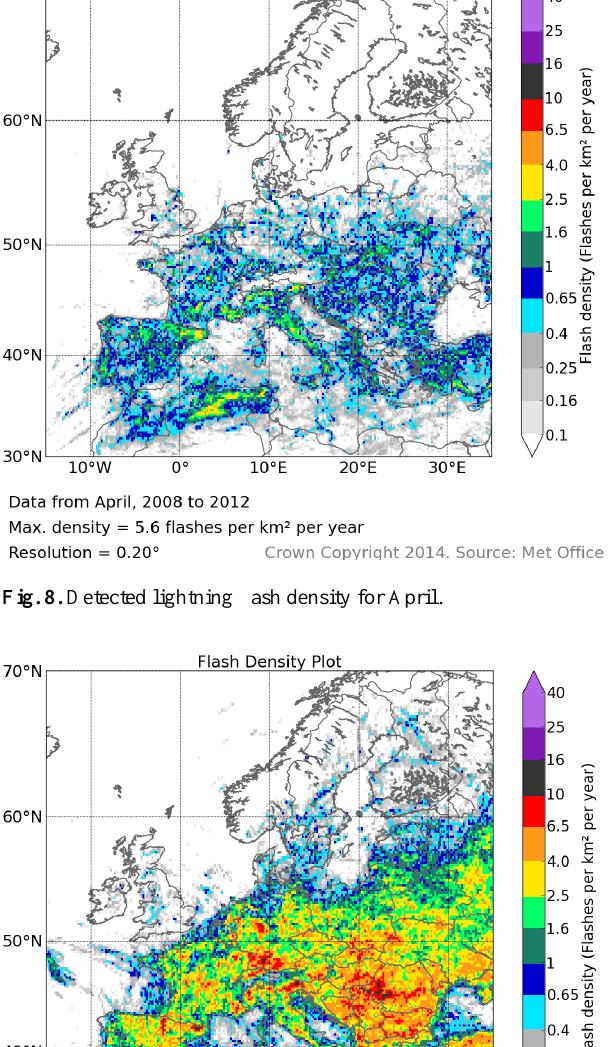
Italian Apennines, the Pyrenees and the lower slopes of the Alps now show the highest flash densities. The heart of the Alps still show very little lightning activity however, which will be further examined in its own section later.